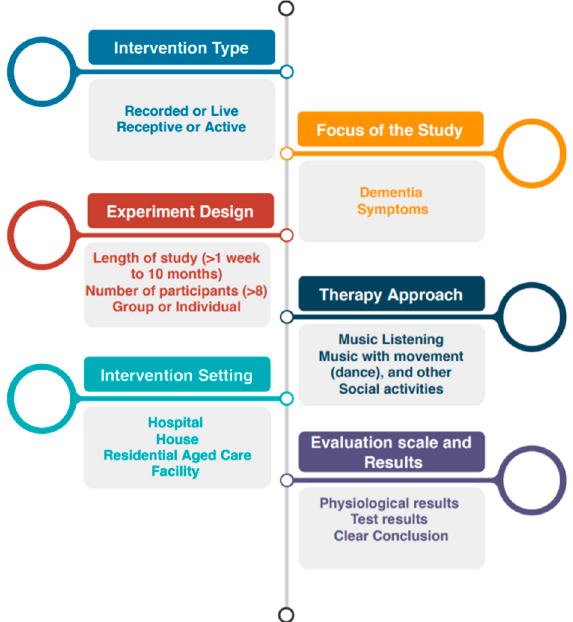
Figure 2. Inclusion criteria of studies.